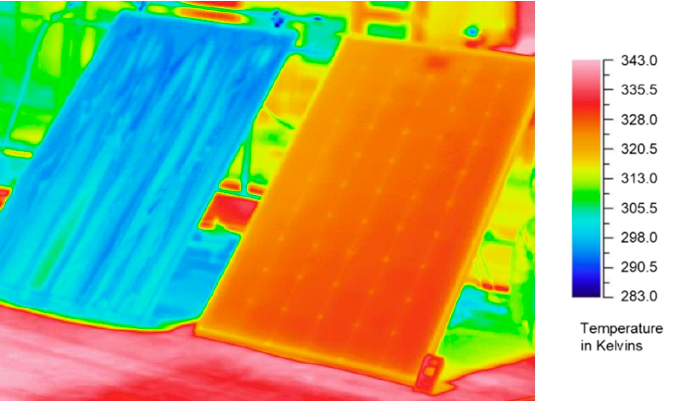
Figure 12. Thermal images show the temperature on the front surface of the tested 310 Wp PV panel without cooling ( right panel), and with a water cooling system ( left panel).